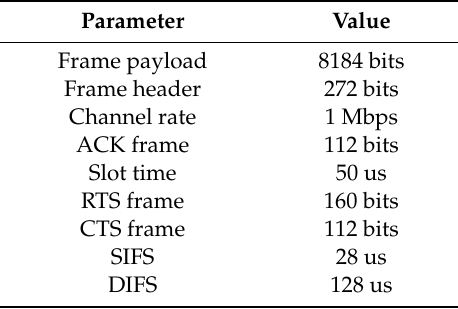
Table 1. Value of each simulation